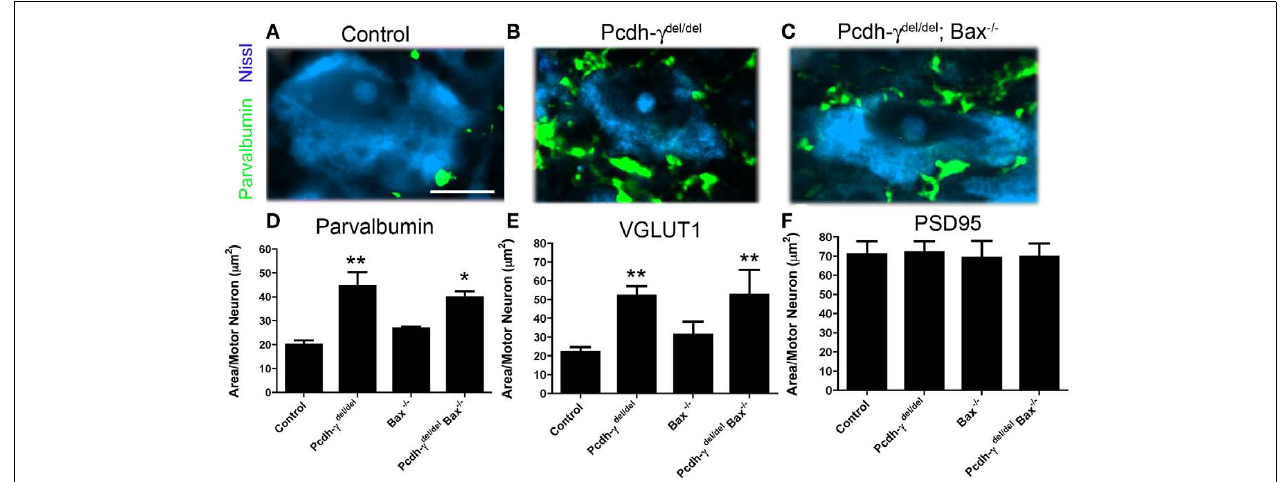
VGLUT1 + terminals in the absence of the γ -Pcdhs is ameliorated when apoptosis is blocked by the additional mutation of Bax . Double mutant terminals are, however, still significantly affected compared to Bax − / − single mutant controls. No effect on the area covered by PSD-95 + puncta is observed. Scale bar: 20 μ m. * p < 0.05 and ** p < 0.01, compared to appropriate control